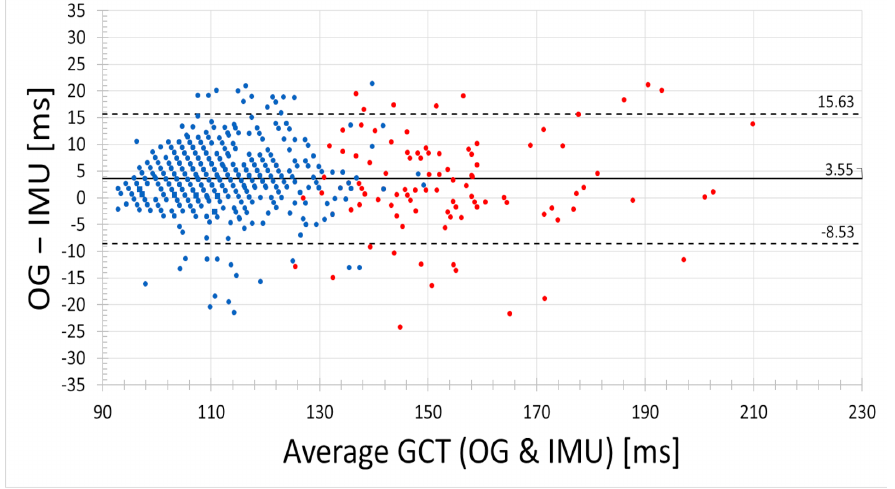
Figure 3. Bland-Altman-Plot of IMU- and Optogait (OG) measured ground contact time (GCT). Dashed lines show Limits of Agreement (2 ∗ SD): − 8.53 ms and 15.63 ms, the dotted line the mean: 3.55 ms. Red data points represent steps 1–5 at the beginning of the sprint. Blue-colored dots indicate all other steps (i.e., step 6–50).